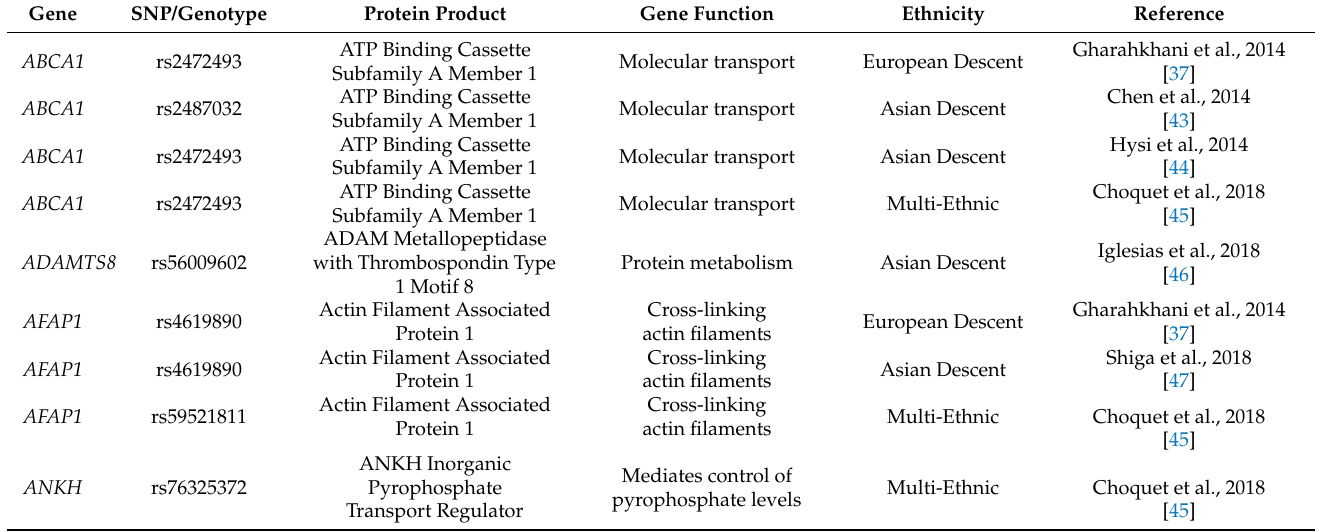
Table 1. Genes associated with primary open-angle glaucoma and normal tension glaucoma. SNP: single nucleotide